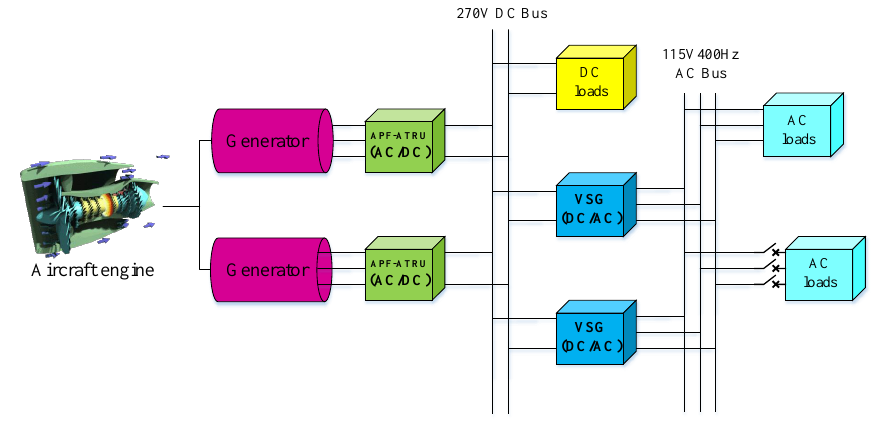
Figure 2. MEA AC/DC hybrid electrical power